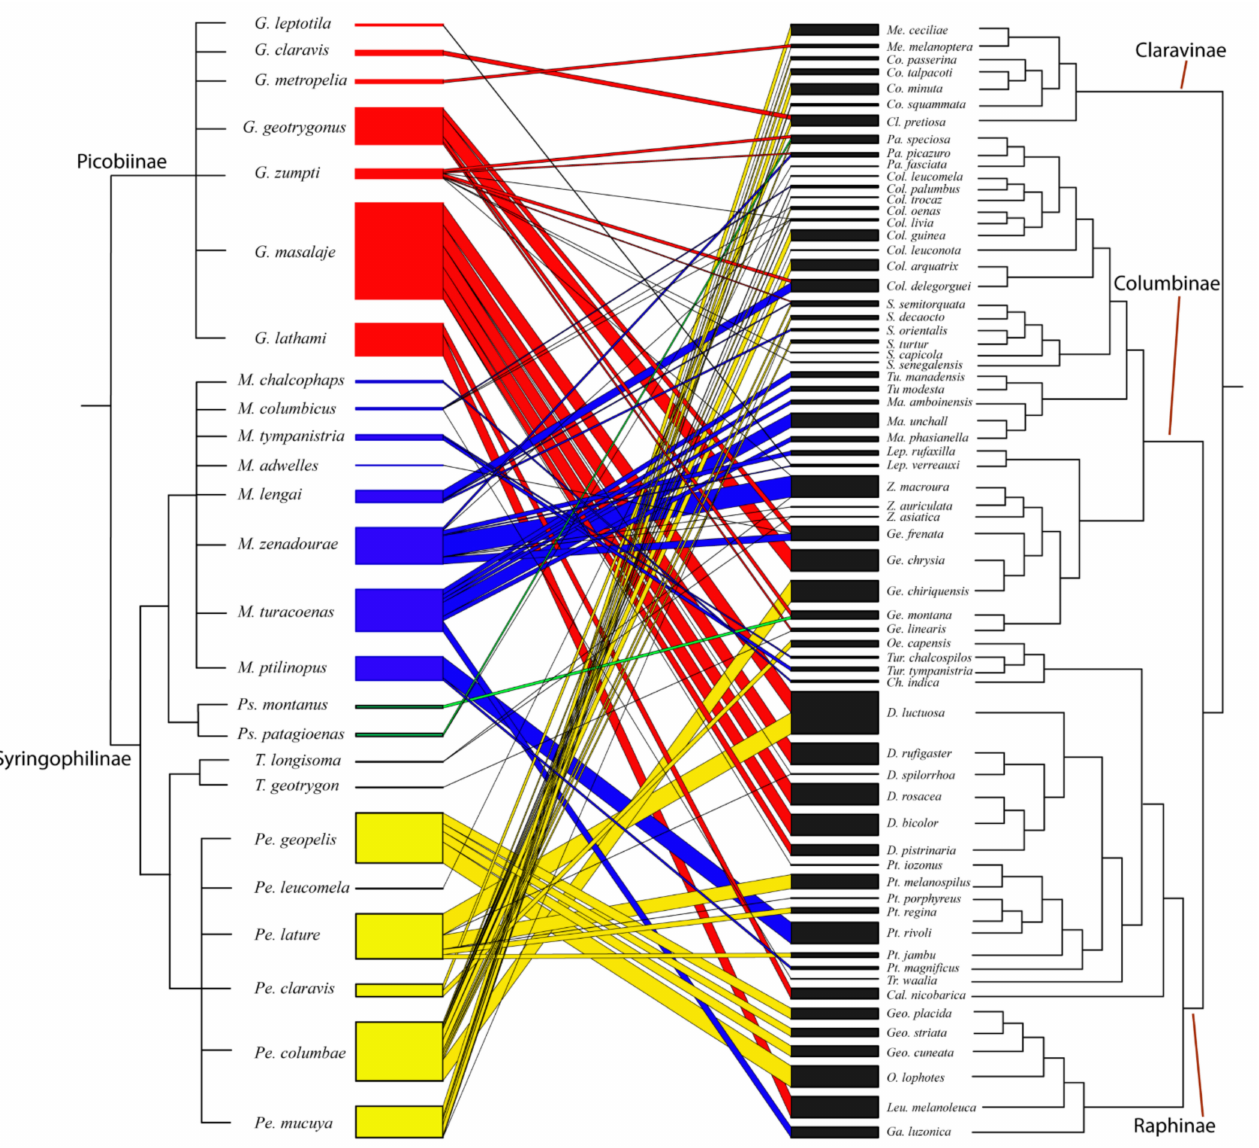
Figure 1. Bipartite network graph of interactions between quill mite species ( left ) and their doves and pigeons hosts ( right